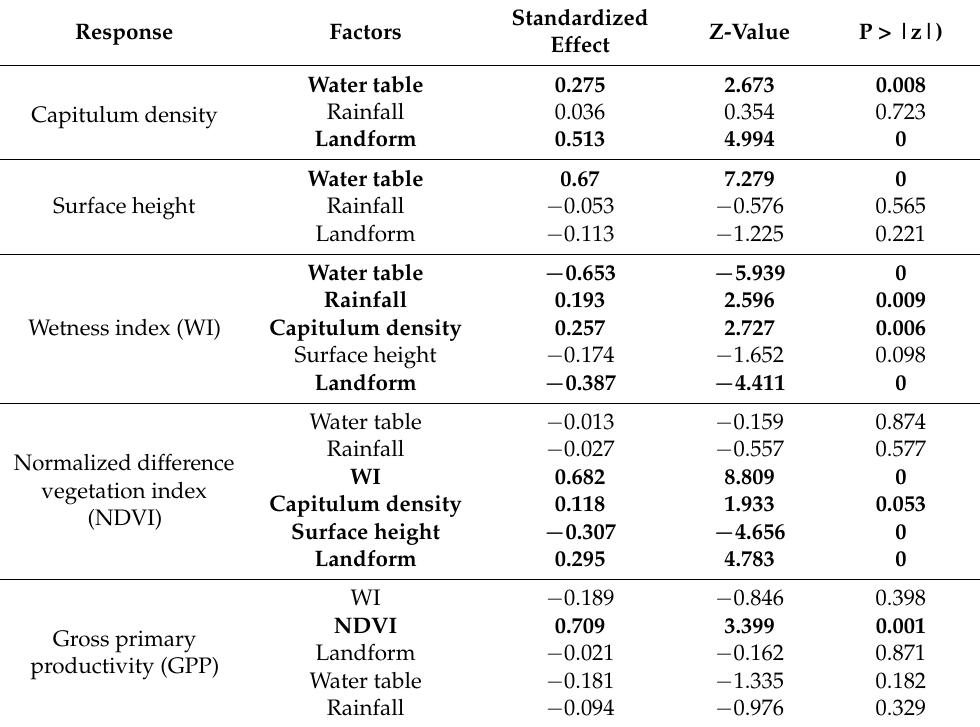
Table 1. Statistics for structural equation model presented in Figure 4. Significant effects are high- lighted in